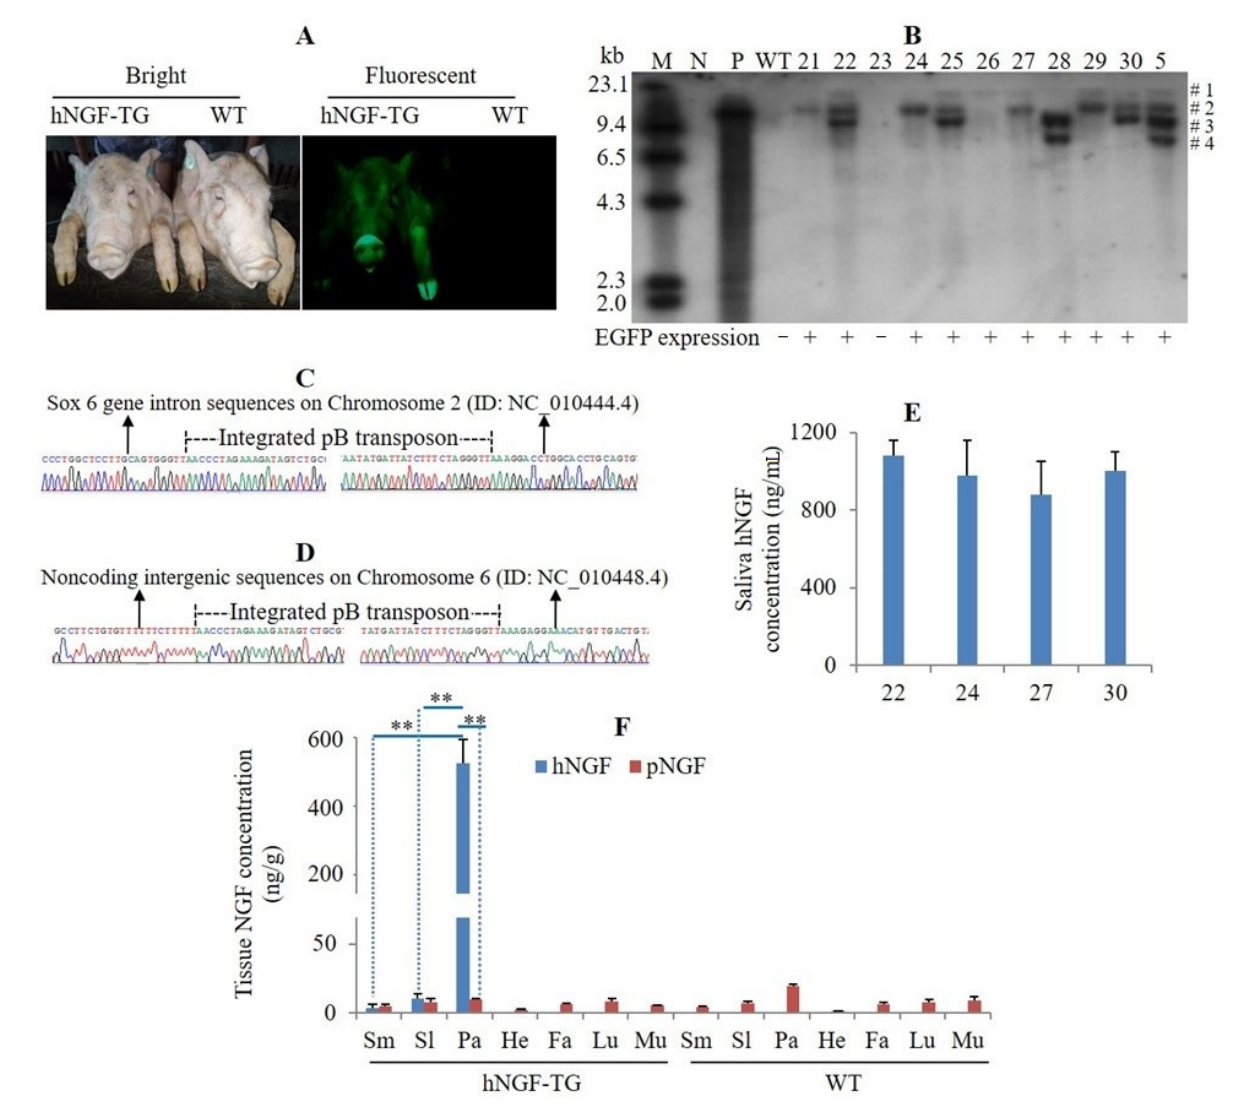
Figure 3. Production and analysis of F 1 generation hNGF ‐ TG pigs. ( A ) EGFP expression in F 1 hNGF ‐ TG pigs produced by mating the no. 5 F 0 hNGF ‐ TG Duroc boar with WT Yorkshire sows (with dominant white coat color). ( B ) Southern blot analysis of transgene integration patterns in the ge ‐